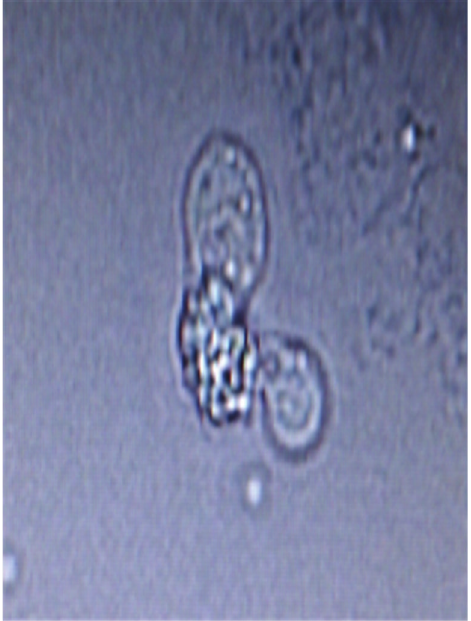
Figure 2: CSF normal saline mount showing Naegleria fowleri with characteristic